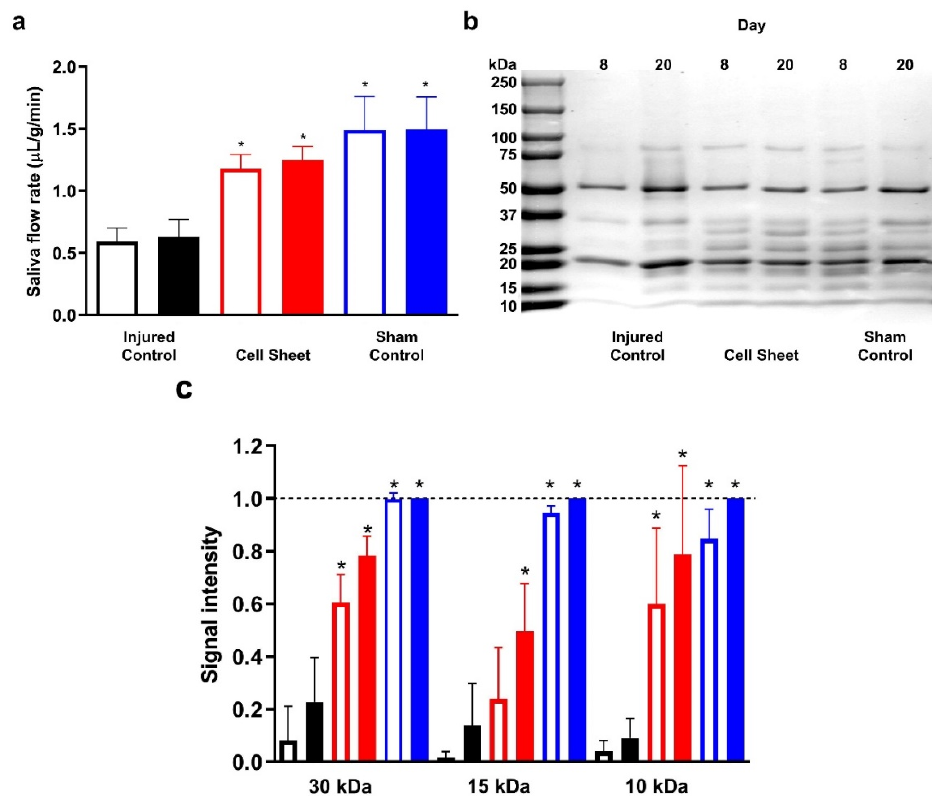
Figure 6. Treatment with cell sheets preserves salivary secretory function. ( a ) As indicated (black bars: injured controls; red bars: cell sheet treatment; blue bars: sham controls) mice were anesthetized and stimulated with pilocarpine and isoproterenol, then saliva was collected for 5 min to determine flow rate. Data are expressed as means ± SD of results from seven independent experiments, where statistical significance was assessed by one-way ANOVA ( p < 0.01) and Dunnett’s post-hoc test for multiple comparisons to injured controls (open bars: Day 8; closed bars: Day 20). ( b ) Saliva protein was fractionated by SDS-PAGE and stained with 0.25% ( w / v ) Coomassie Brilliant Blue R-250 to assess salivary protein patterns in whole saliva and ( c ) signal intensities were compared to injured controls and analyzed using both ImageJ and GraphPad Prism 6. Data are expressed as means ± SD of results from three independent experiments, where statistical significance was assessed by one-way ANOVA ( p < 0.05) and Dunnett’s post-hoc test for multiple comparisons to injured controls at Day 20; * significant difference from injured controls.